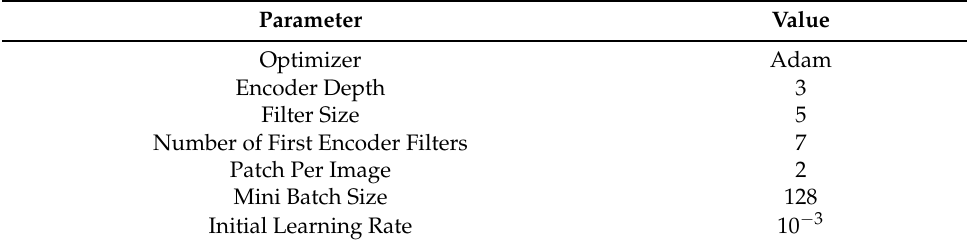
Table 3. Brain Segmentation Implementation